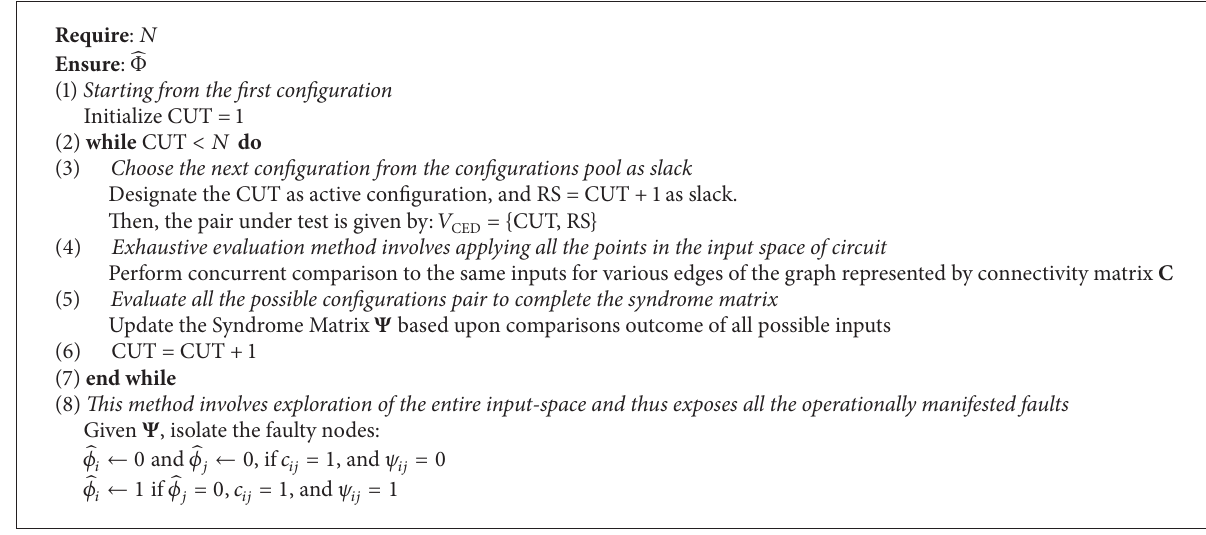
Algorithm 1: Exhaustive evaluation of configurations for fault